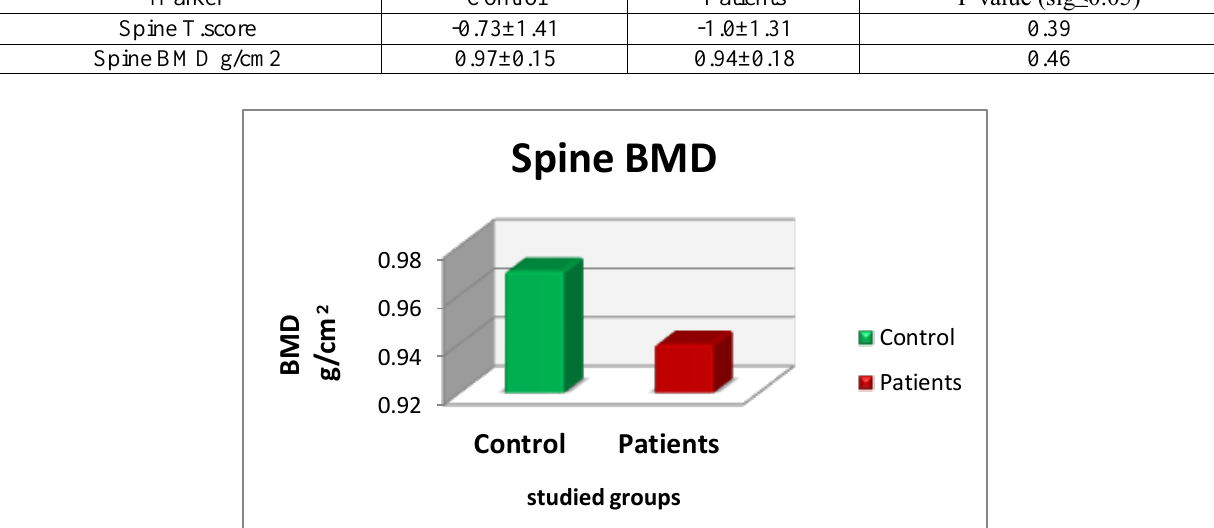
Figure 6: Spine bone mineral density for patients and control